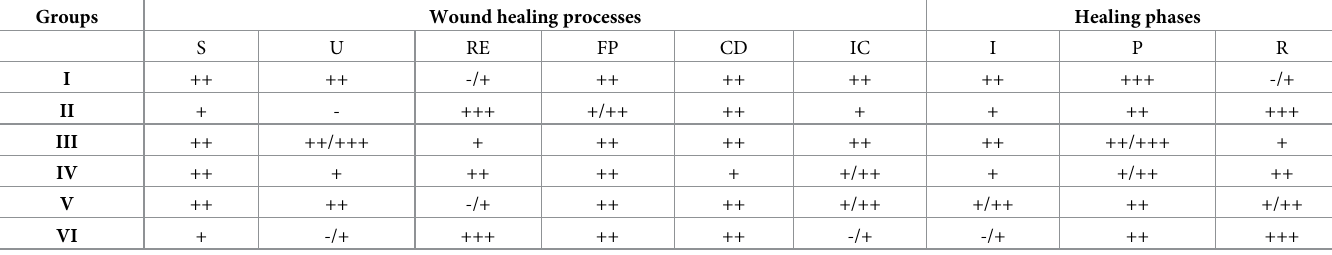
HE (Hematoxylin &Eosin) stained sections were scored as mild (+), moderate (++) and severe (+++) for epidermal and/or dermal re-modeling. S: Scab, U: Ulcus, RE: Re-epithelization, FP:Fibroblast proliferation, CD: Collagen depositions, IC: Inflammatory cells infiltration, I: Inflammation phase, P: Proliferation phase, R: Re- modeling phase.